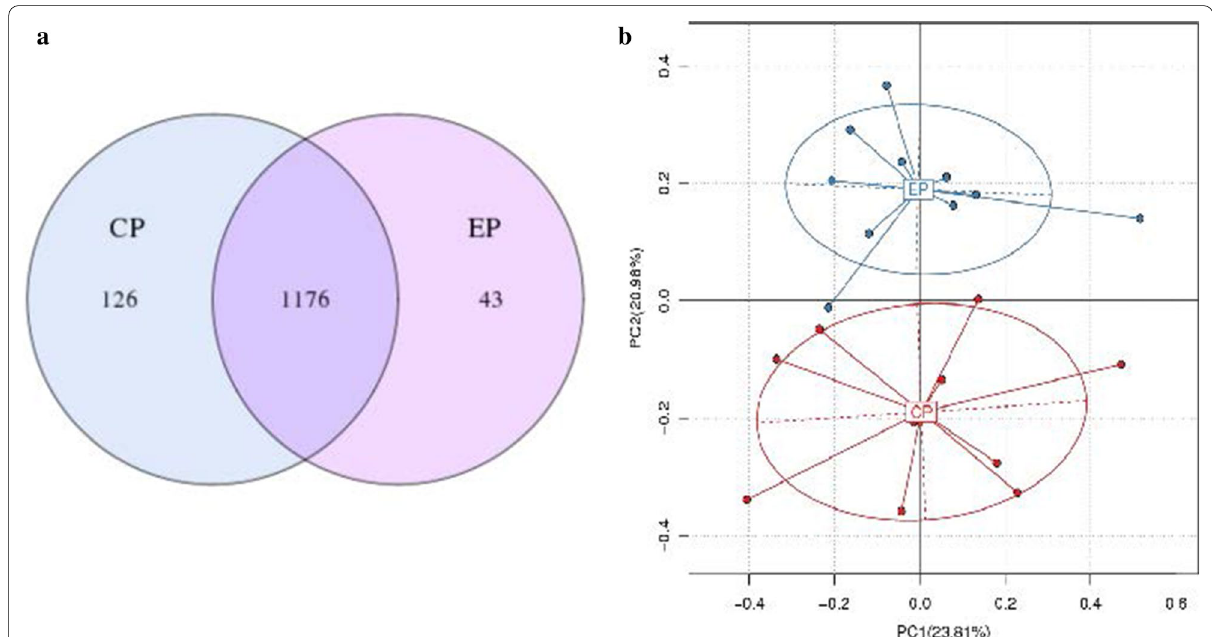
Fig. 1 Cluster analysis of the OTUs in CP and EP pigs. a Venn diagram showing shared and unique genera in the microbial communities in both groups. The OTUs were defined at a 97% sequence similarity level. b PC analysis of the OTUs in the CP and EP groups